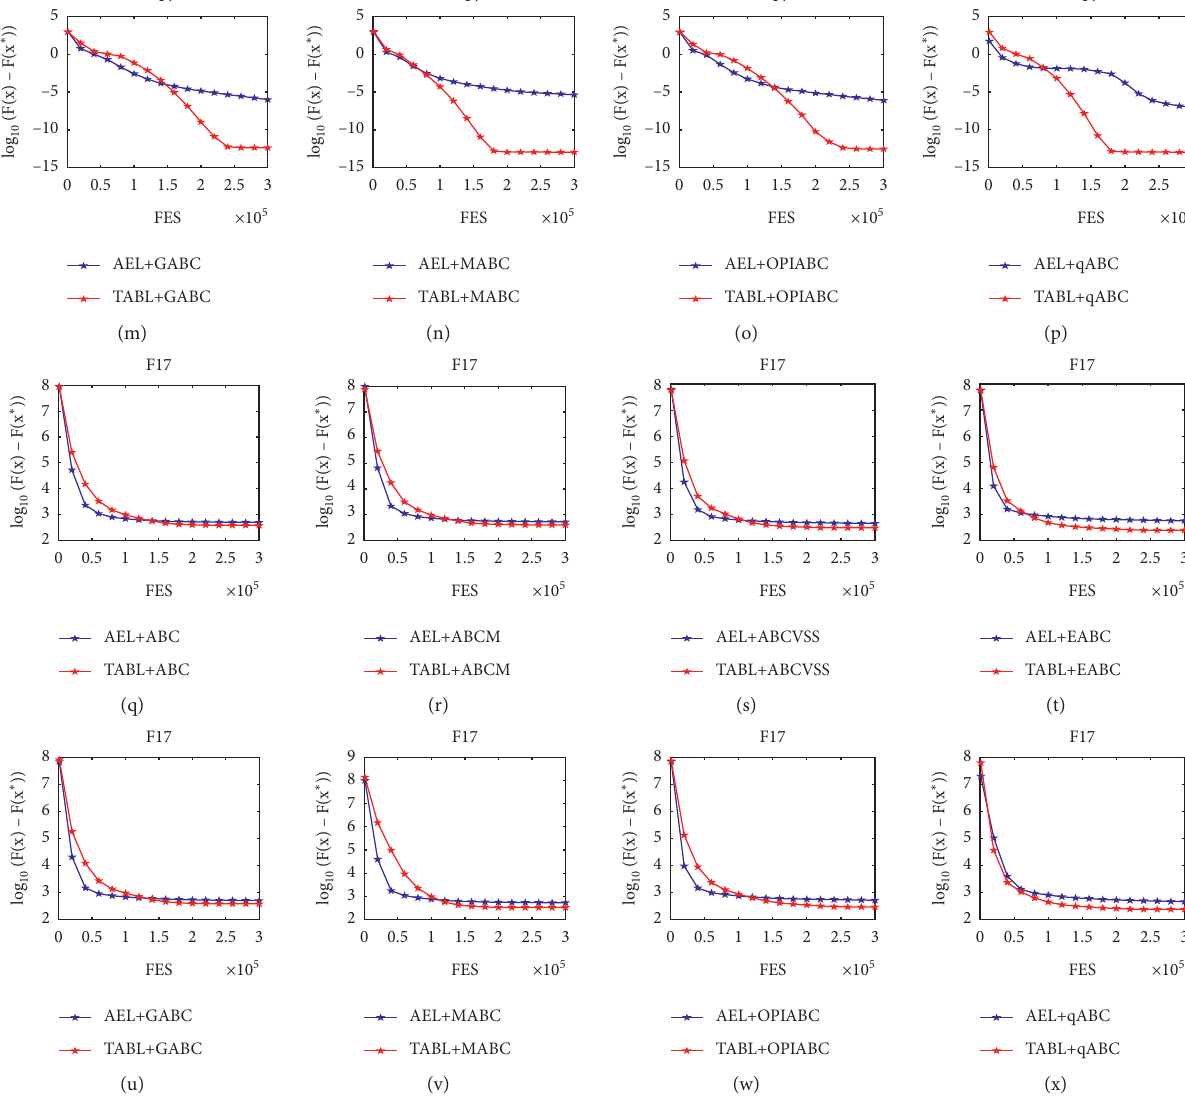
Figure 7: The mean function error values versus numbers of function evaluations for eight groups of AEL+ABCs vs. TABL+ ABCs over 51 independent runs on F1, F7, and F17 with 30 D ,